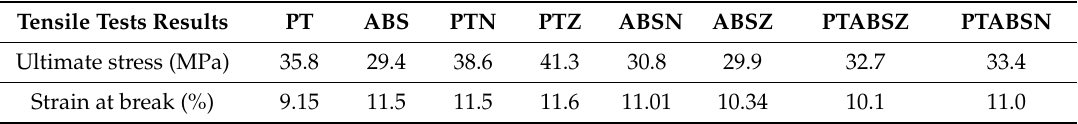
Table 3. Mechanical properties of samples tested.